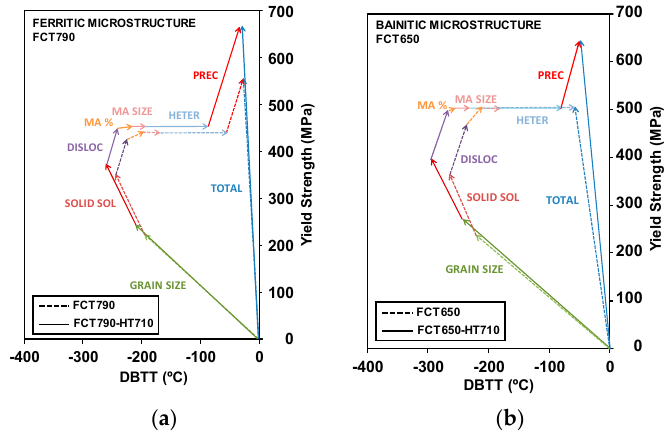
Figure 19. Relative contribution of each metallurgical parameter (grain size, solid solution, dislocations, martensite/austenite (MA) fraction, MA size, heterogeneity and precipitation) on both strength and toughness properties. FCT and FCT-HT conditions are compared for both types of microstructures: ( a ) ferritic in FCT790 and ( b ) bainitic in FCT650.